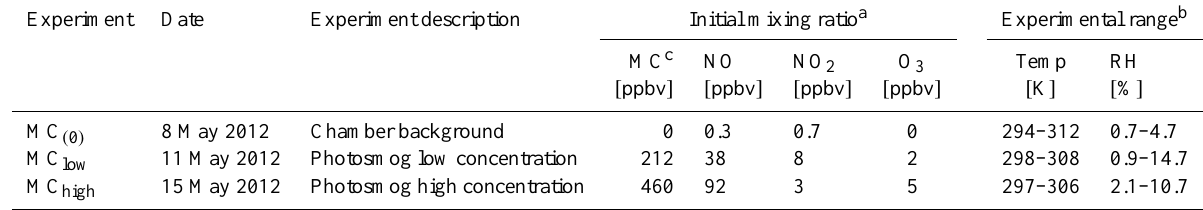
Table 1. The initial experimental mixing ratios, temperature and relative humidity range for the experiments discussed.